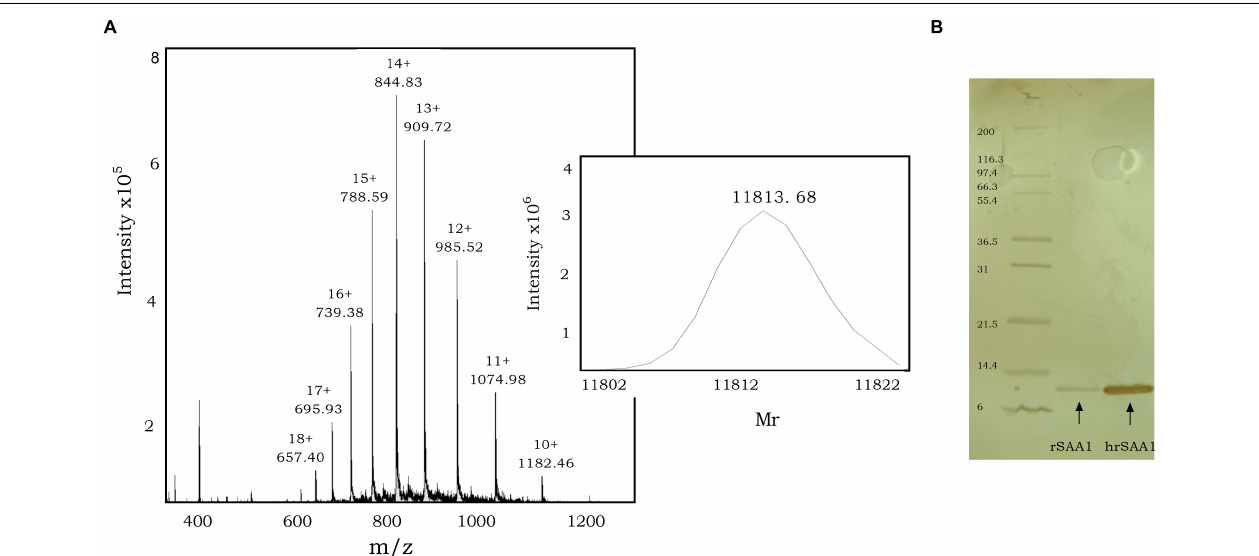
FIGURE 1 | Purification of rSAA1 using RP-HPLC to homogeneity. (A) Relative molecular mass determination of RP-HPLC-purified homogenous rSAA1 (hrSAA1) by mass spectrometry. The averaged mass spectrum of the pooled hrSAA1 fractions is shown with the ion intensities, the number of charges and the corresponding mass over charge ratio (m/z) for multiple charged ions. The experimentally determined deconvoluted mass spectrum of uncharged hrSAA1, as calculated by the Bruker deconvolution software, is shown as an insert at the right of the mass spectrum. (B) Homogenous rSAA1 (hrSAA1; 200 ng) was analyzed in parallel to rSAA1 (20 ng) using SDS–PAGE and silver staining. The molecular mass of the standard marker proteins is indicated in kilodalton.